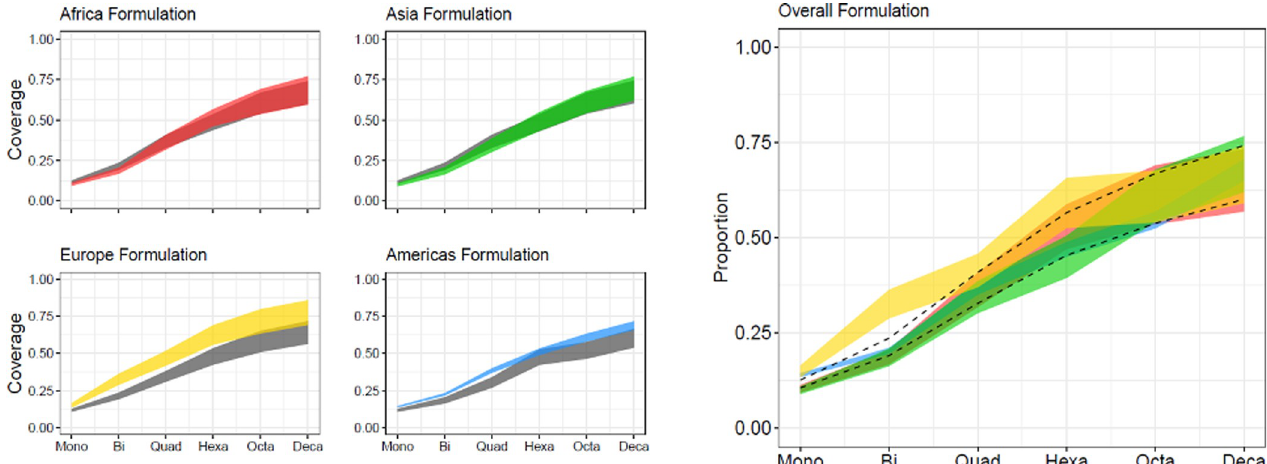
Fig 3. Estimates of the proportion of C . jejuni isolate coverage for a capsule-conjugate-based vaccine by region and valency using (a) region-specific and (b) global formulations. (a) The x-axis represents the coverage by a stepwise addition of the most prevalent capsule types in each region (mono = monovalent, bi = bivalent, quad = quadrivalent, hexa = hexavalent, octa = octavalent, deca = decavalent) and the y-axis represents the estimated coverage calculated by the pooled prevalence of the proposed vaccine. The shaded region shows the estimated coverage, with the lower bound including non-typable isolates in the pooled prevalence calculations and the upper bound excluding non-typable isolates. The colored area (red = Africa, green = Asia, yellow = Europe, and blue = Americas) represents the coverage achieved by a region-specific formulation (S2 Table). The gray area represents the global coverage with the use of each respective region-specific formula. (b) The x-axis represents the coverage by a stepwise addition of the most prevalent capsule types globally (mono = monovalent, bi = bivalent, quad = quadrivalent, hexa = hexavalent, octa = octavalent, deca = decavalent) and the y-axis represents the estimated coverage calculated by the pooled prevalence of the proposed vaccine. The dotted lines show the estimated coverage of the global vaccine formulation if applied to all regions (globally). The colored regions (red = Africa, blue = Americas, green = Asia, and yellow = Europe) show the estimated coverage of the global vaccine formulation in each individual region (S2 Table). The lower bound represents the estimated coverage including non-typable isolates in the pooled prevalence calculations and the upper bound represents the estimated coverage excluding non-typable isolates.